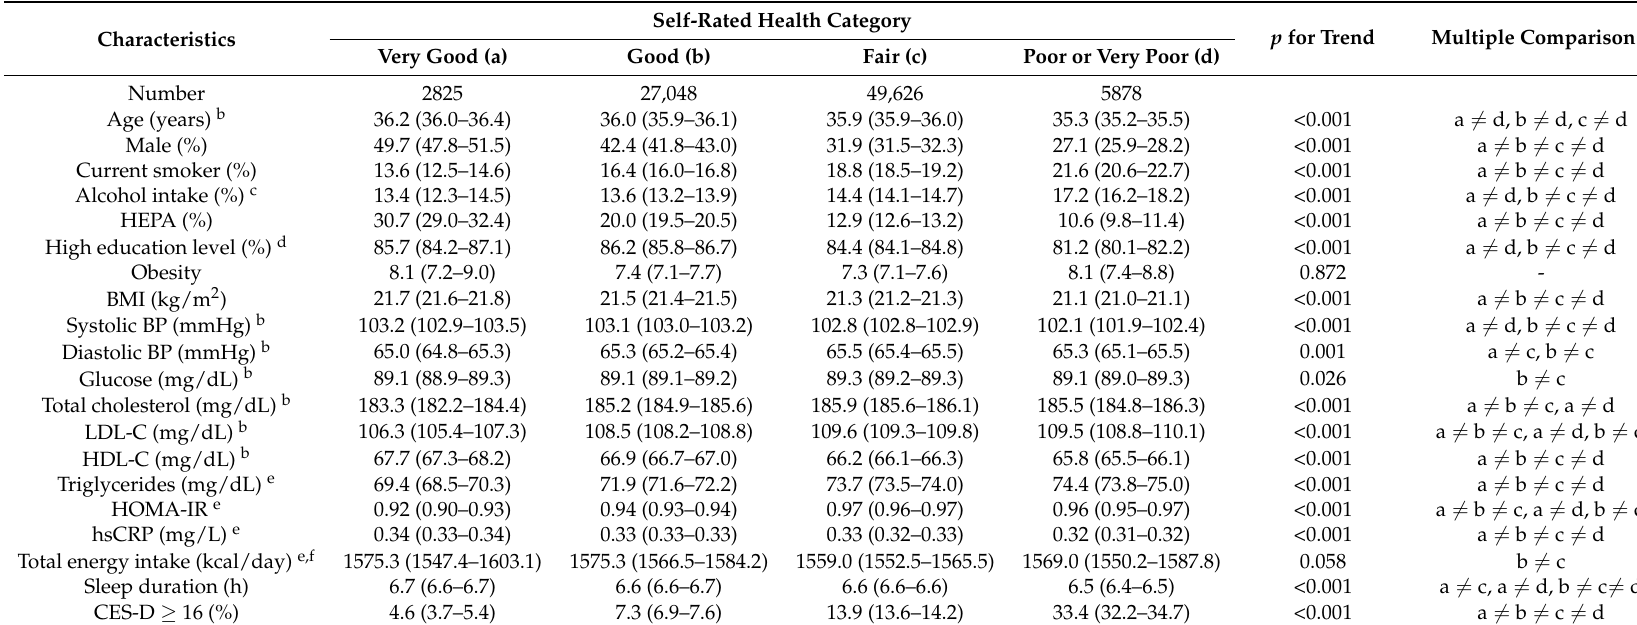
Table A1. Estimated a mean values (95% CI) and adjusted a proportion (95% CI) of baseline characteristics of study participants by self-rated